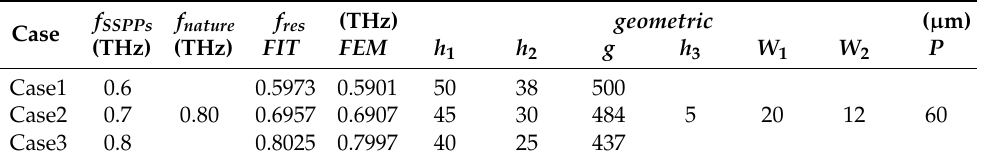
Table 4. Geometric parameters without